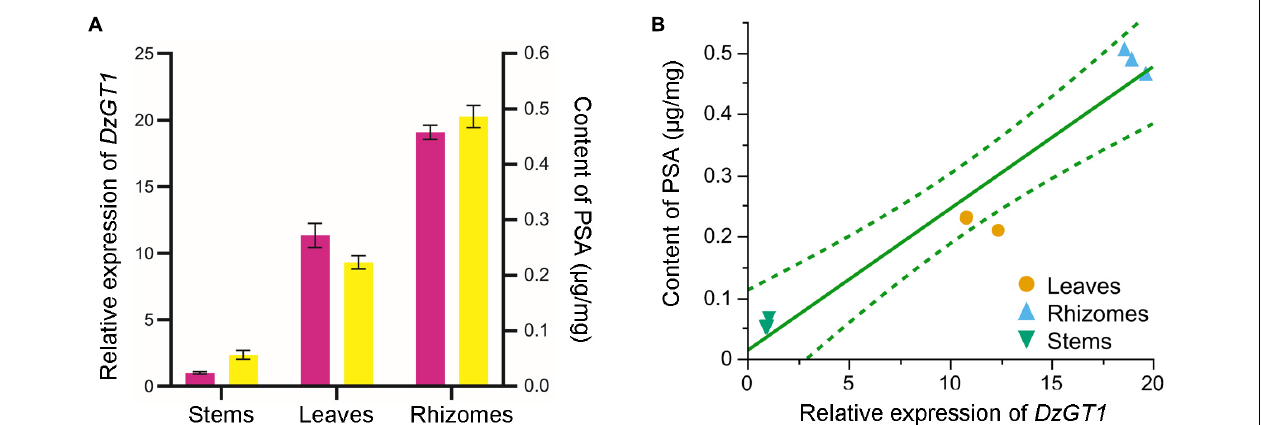
FIGURE 4 | Correlation analysis of the DzGT1 transcript abundance with the accumulation of the prosapogenin A of dioscin (PSA) in Dioscorea zingiberensis . (A) The relative transcript level of the DzGT1 (magenta bar) and the content of PSA (yellow bar) in the different organs of D. zingiberensis . The D. zingiberensis actin gene was used as an internal standard for the gene expression analysis. Values are means ± SD of three biological replicates. Data was analyzed by GraphPad Prism 5.01 software. (B) The correlation between the content of PSA and the relative expression of DzGT1 analyzed by Fit Y by X platform of JMP Pro 16. The linear fit equation is Y = 0.012629 + 0.0231855 *X and R 2 = 0.940799, showing the high correlation between PSA content and the relative expression of DzGT1 . The dotted lines display a 99% confidence